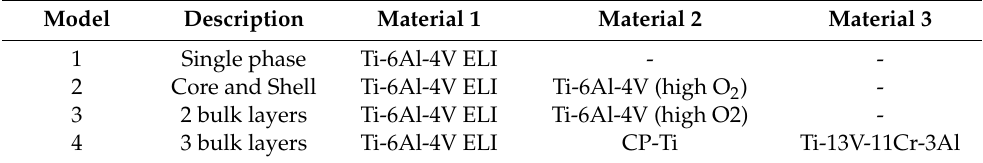
Table 1. Initial billet condition.